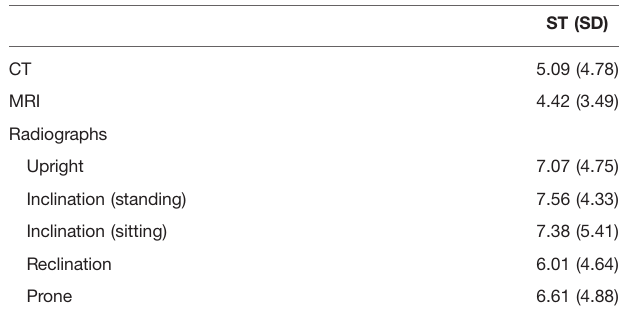
TABLE 2 | Sagittal